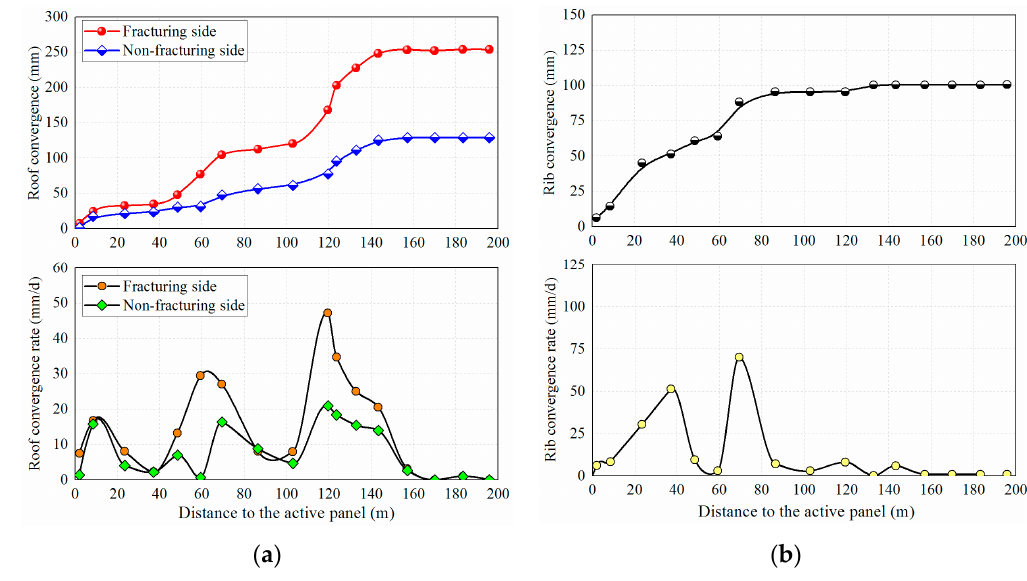
Figure 21. Monitoring results of the entry deformation: ( a ) Convergences and convergence rates of the roof to floor at the fracturing and non-fracturing sides; ( b ) Convergence and convergence rate of the gangue rib to coal rib.